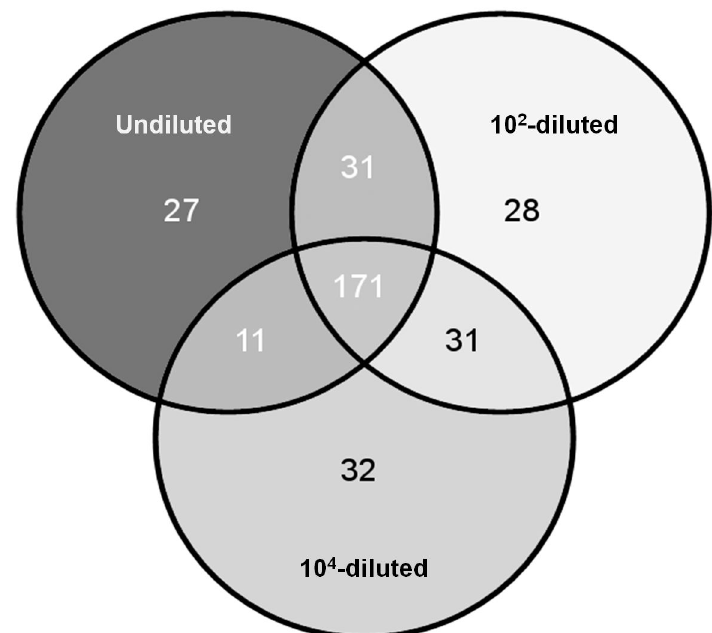
Figure 6. Venn diagram representing shared and unique rare genera (< 1% of total reads) of microcosms.